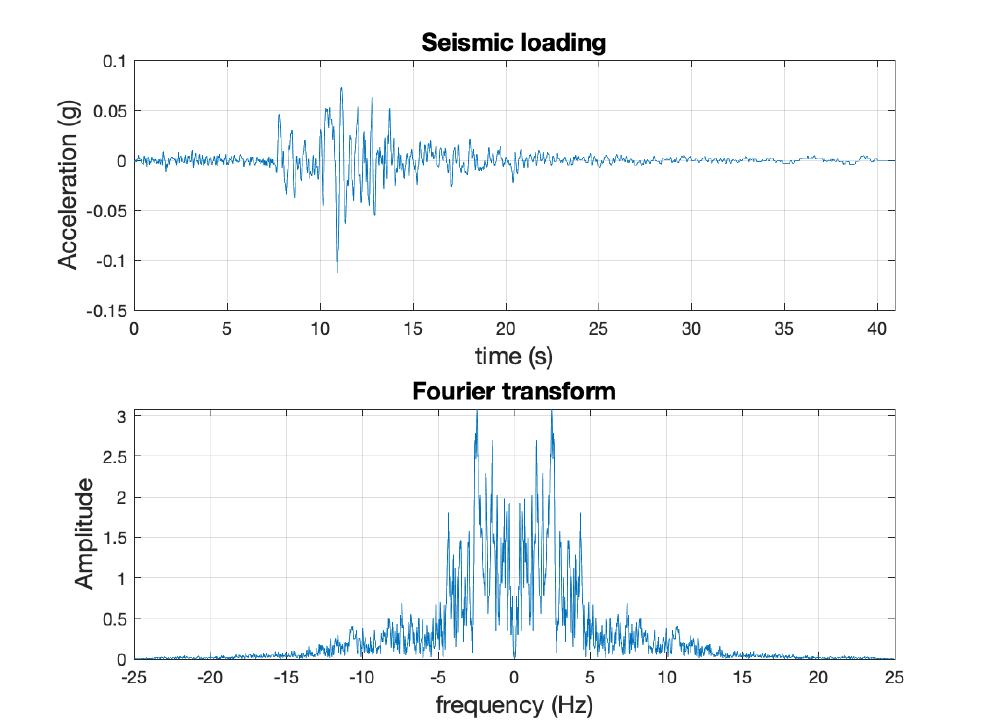
Figure 1. Top: Acceleration time history for Diamond Heights station during Loma Prieta earthquake (1989); bottom: Fourier transform.